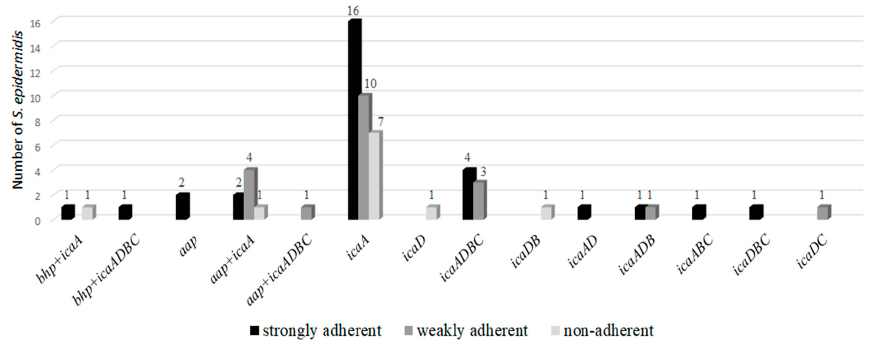
Figure 1. Correlation between adherence and expression of the detected genes.